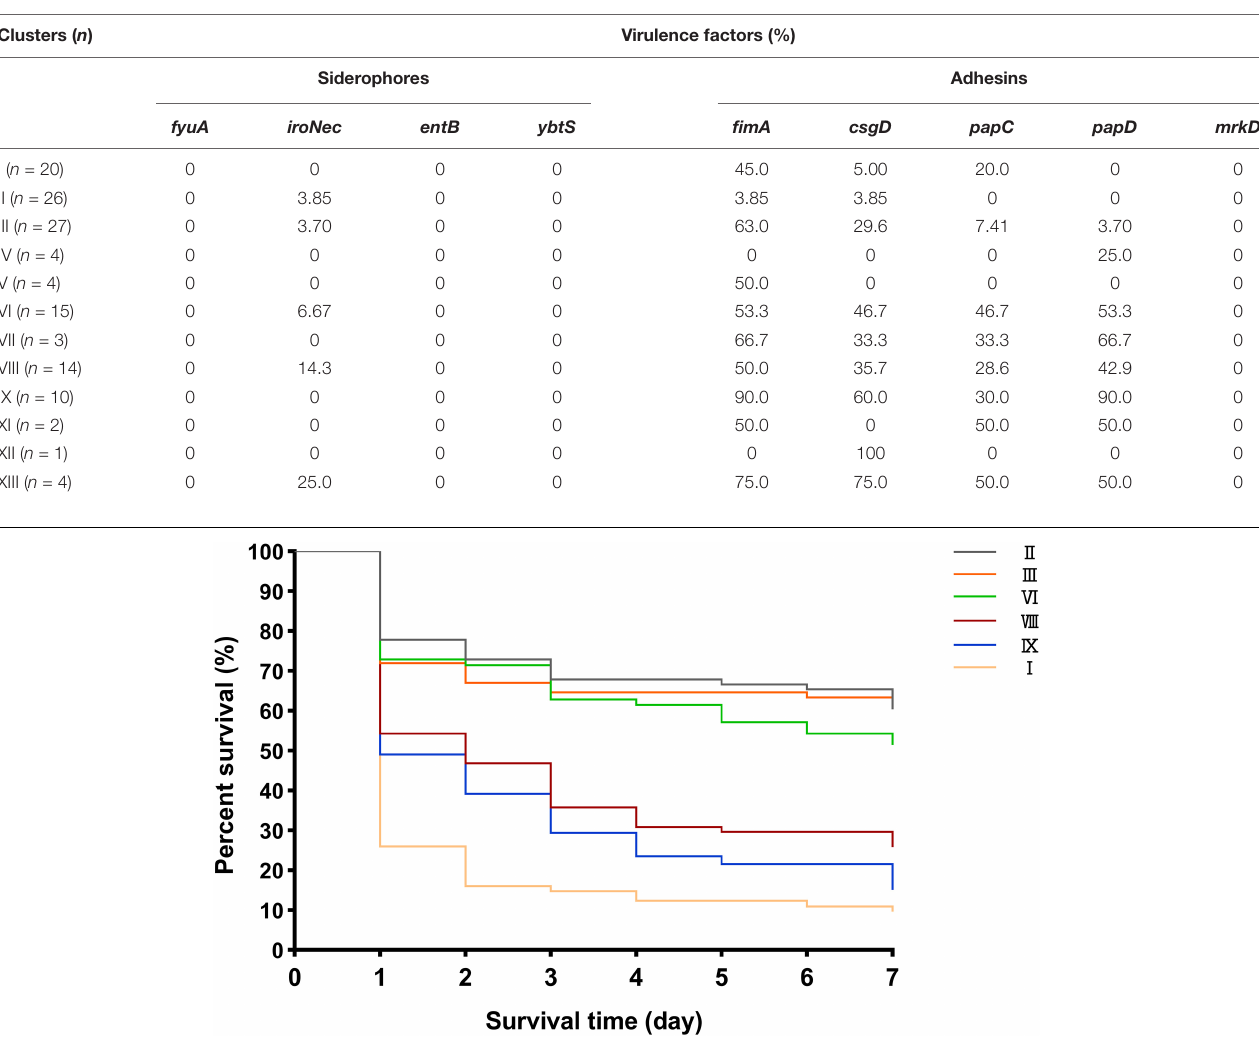
FIGURE 7 | Different survival rates of G. mellonella infection model in clusters VIII, VI, III, II, I, and IX.